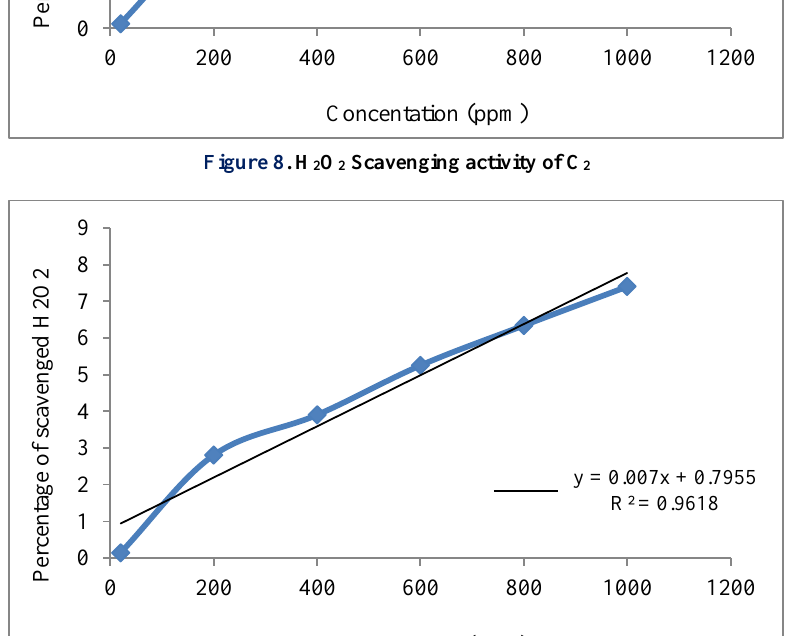
Figure 9. H 2 O 2 Scavenging activity of C